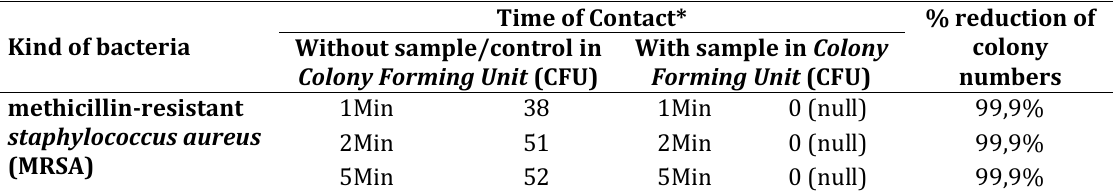
Table IV. Percentage of bacterial killing test results on formula MK.4 Time of Contact* Kind of bacteria Without sample/control in Colony Forming Unit